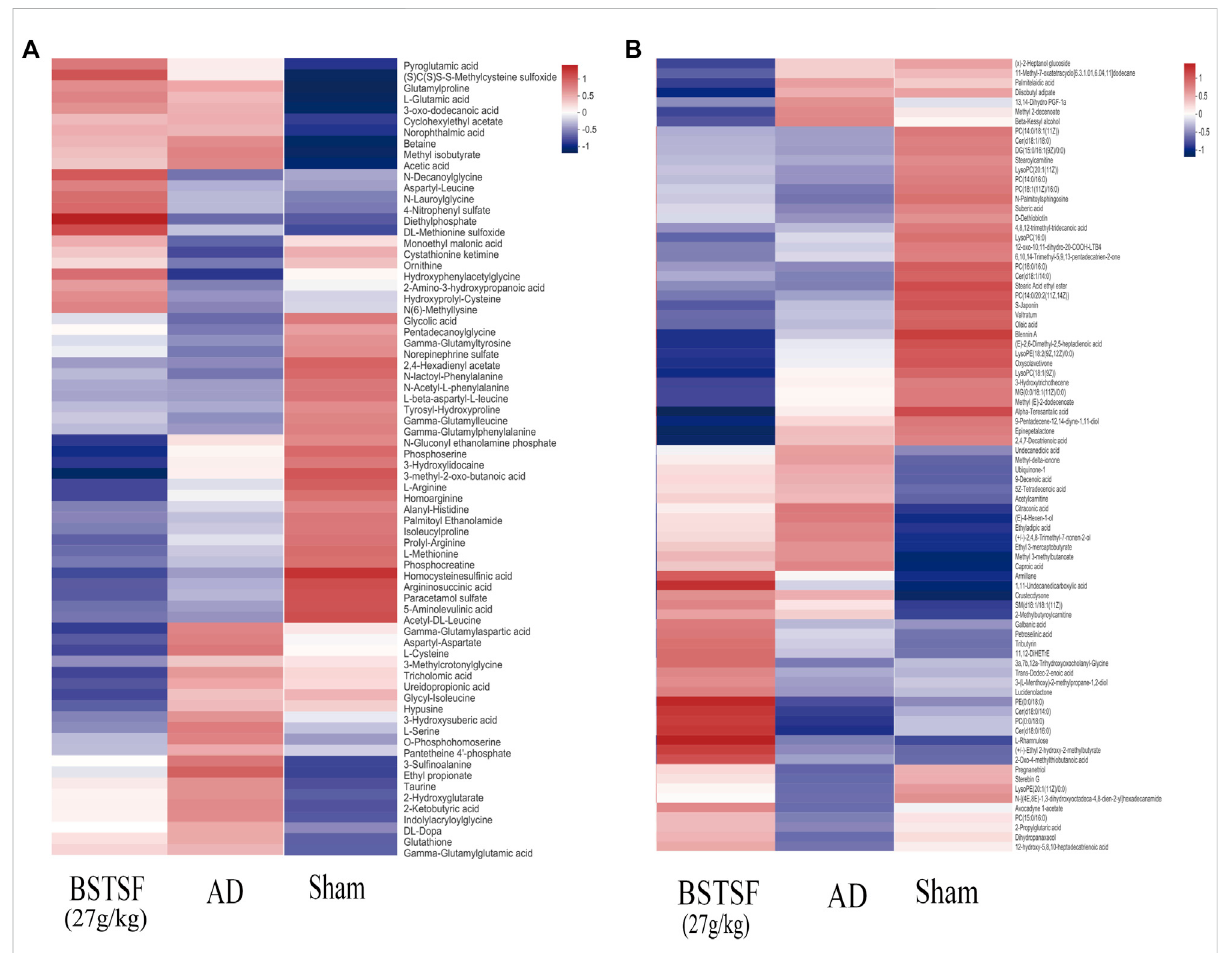
FIGURE 5 Heat map of differential metabolites in the cerebral cortex. (A) organic acid metabolites; (B) lipid